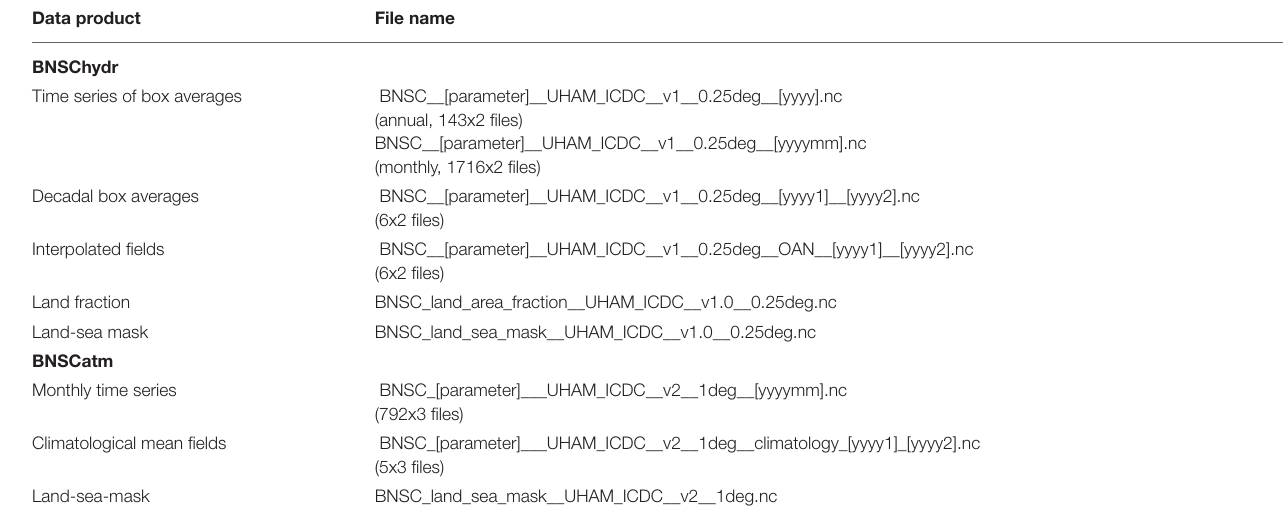
TABLE 5 | File names of BNSC data